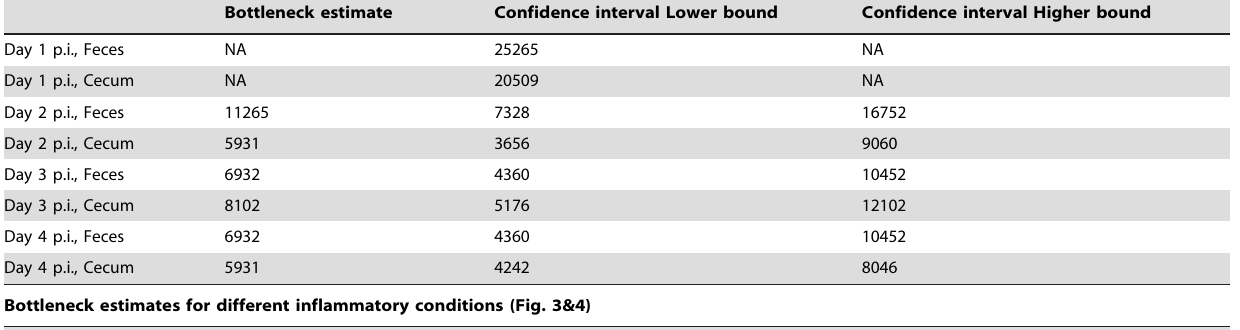
Table 2. Bottleneck estimates.